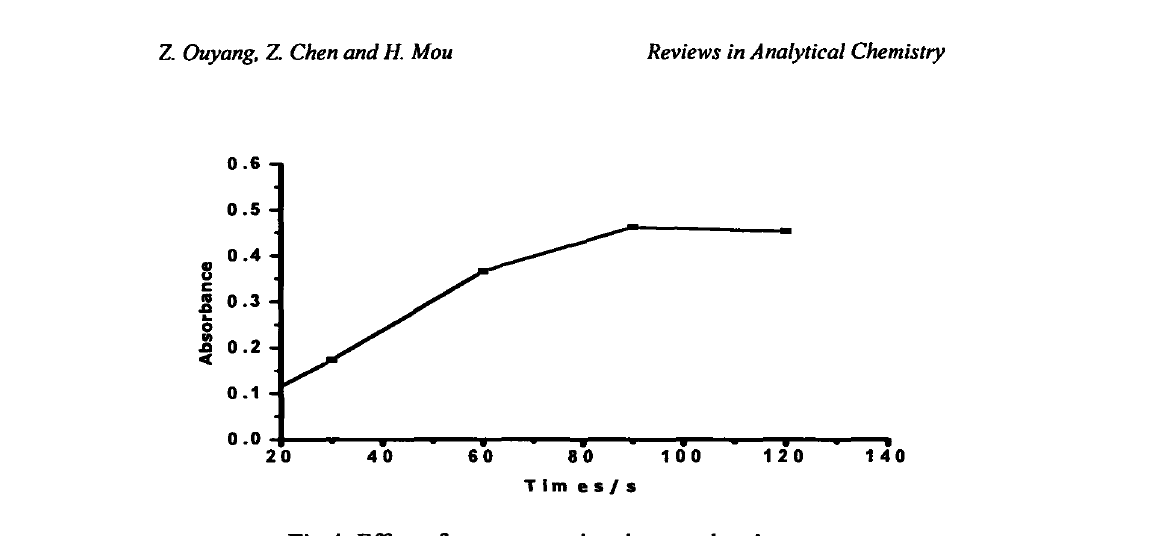
Fig 4: Effect of preconcenration time on